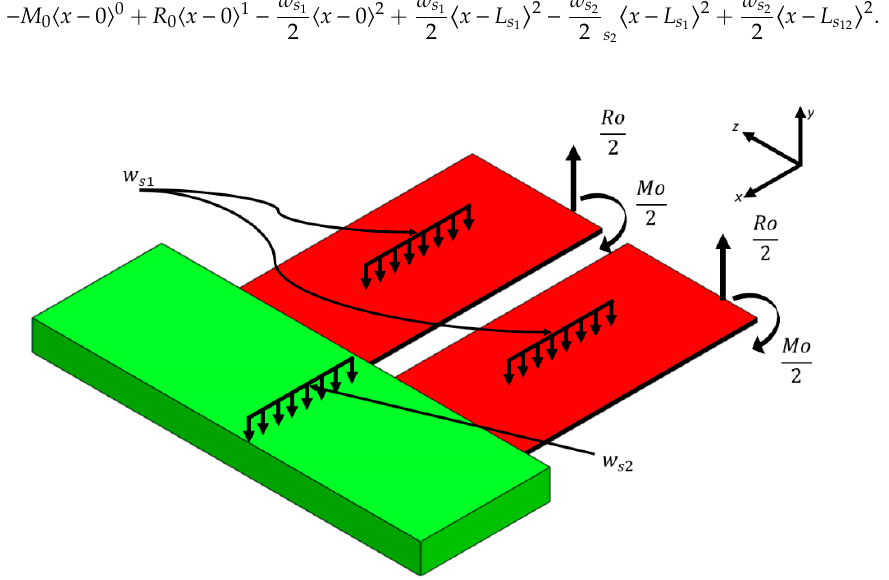
Figure 3. Schematic view of the loads applied on the surface of the PEH devices.